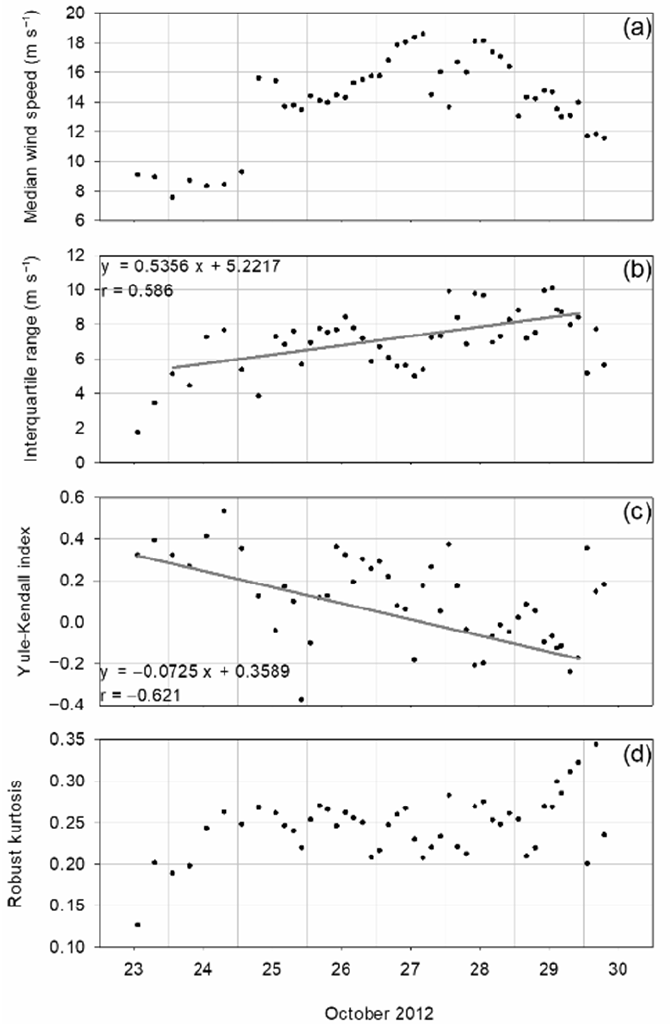
Figure 4. ( a ) Median wind speed, where the sharp transition on 25 October 2012 was the most noticeable feature. ( b ) Interquartile wind speed range, showing a steady increase from 24 to 29 Oc- tober 2012. ( c ) Yule–Kendall index of wind speed with a sharp dispersion of values and a decrease from slightly right-skewed to slightly left-skewed distributions. ( d ) Robust kurtosis of wind speed, where the dispersion of values increased with time (intercepts of linear fits were considered in the first file, on 23 October 2012 at 13.30 UTC, and slopes display the rate of change per